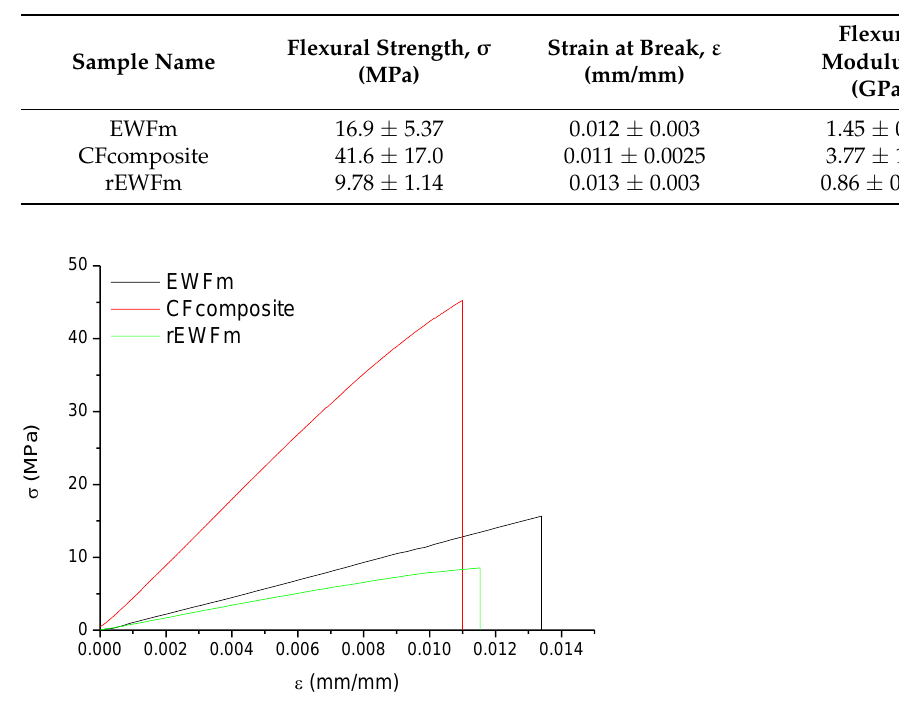
Table 2. Flexural properties of EWF-based epoxy systems and composite.